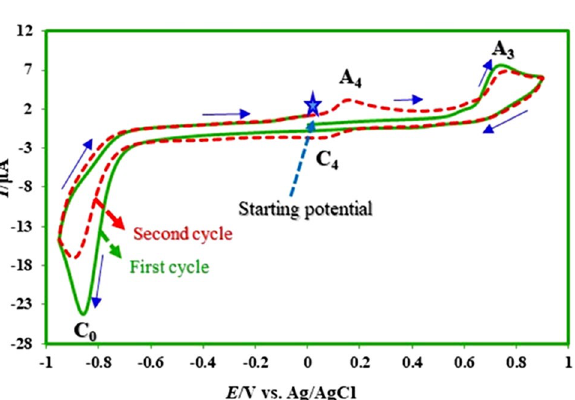
Figure 16. Cyclic voltammograms (first and second cycle) for a saturated solution of nitromefenamic acid at a glassy carbon electrode, in phosphate buffer solution (c = 0.2 M, pH 7.0); scan rate: 100 mV s −1 ; room